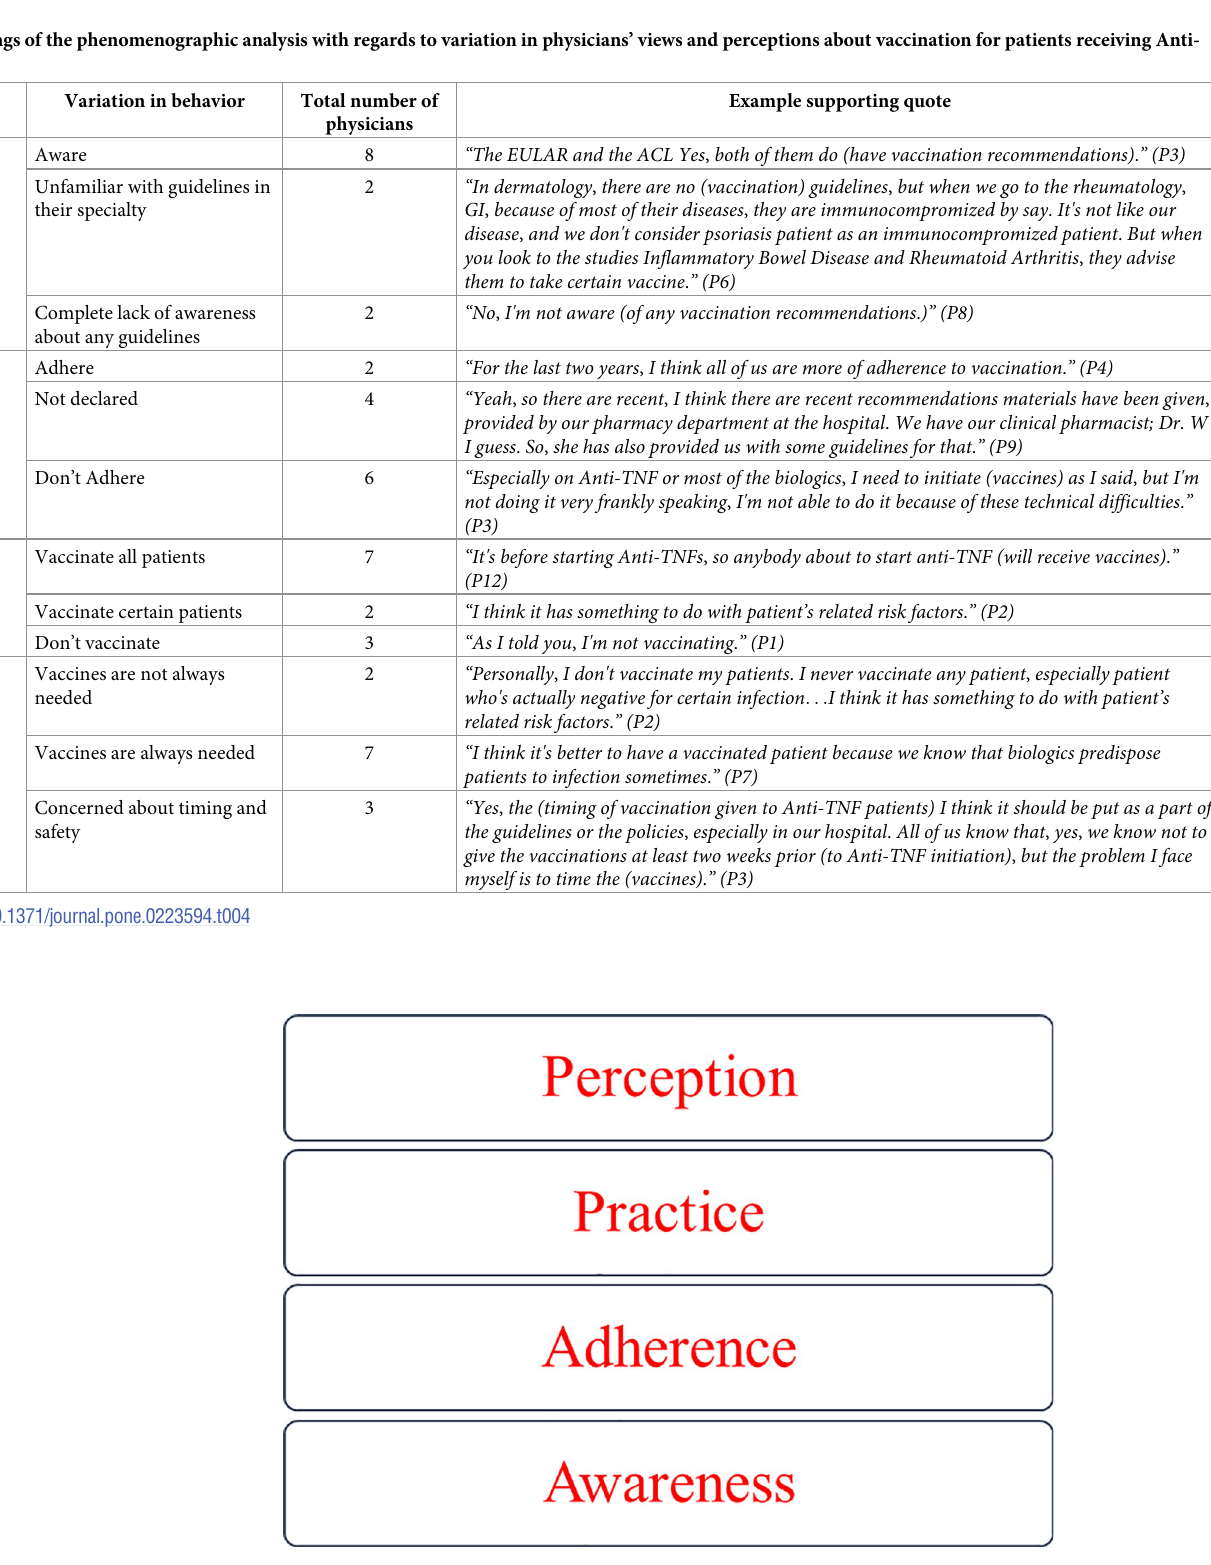
Fig 2. Outcome Space arranged from the least complex dimension from the bottom the most complex at the top.